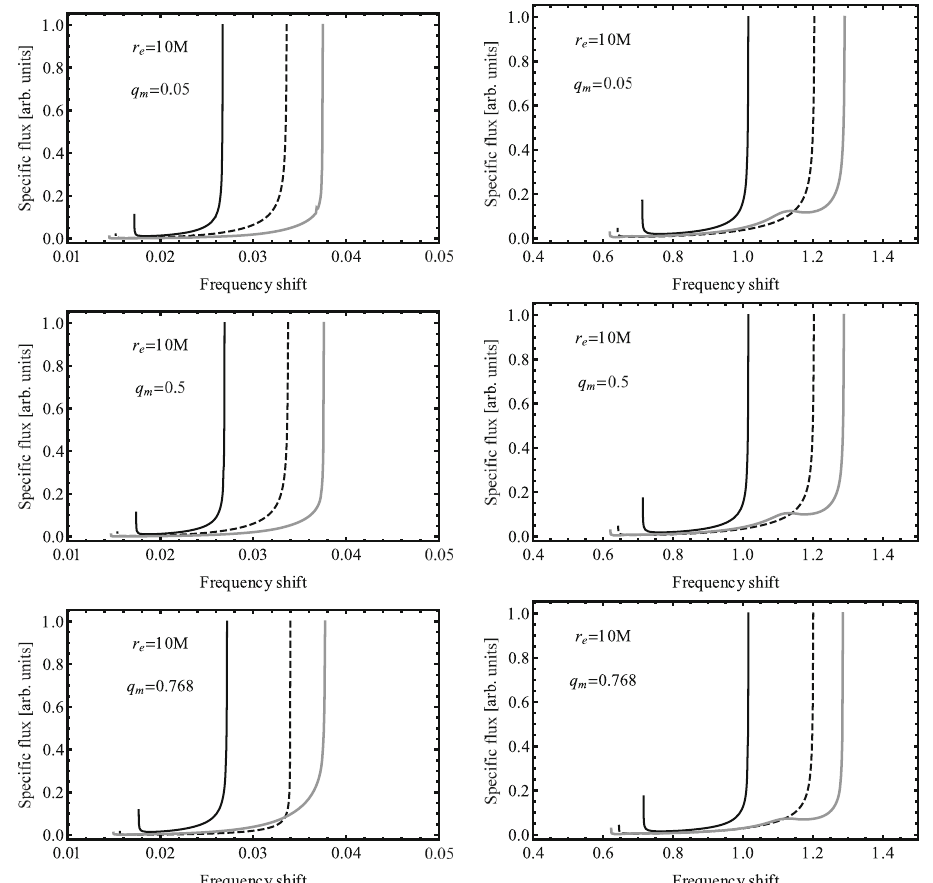
Fig. 5 Ring profiled spectral line generated. Illustration of observer inclination angle effect on spectral line properties constructed for three representative values of “magnetic charge” parameter q m = 0 . 05 M (top), 0 . 5 M , and 0 . 768 M (bottom) and three values of observer’s inclination angles θ o = 30 ◦ (black), 60 ◦ (black, dashed), and 85 ◦ (thick, gray). The ring radius is r e =